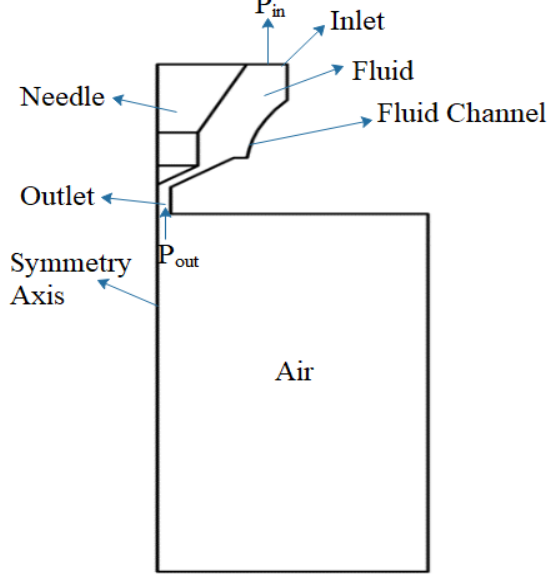
Figure 5. Schematic view of spray simulation boundary conditions.